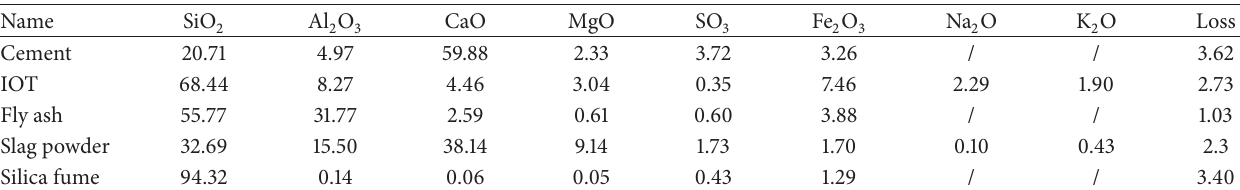
Table 1: Chemical component (%).